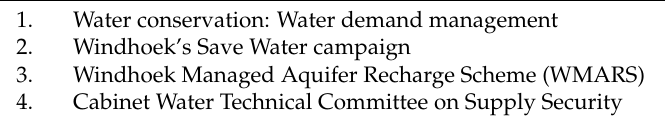
Table 1. The four reactions to the drought and water insecurity in